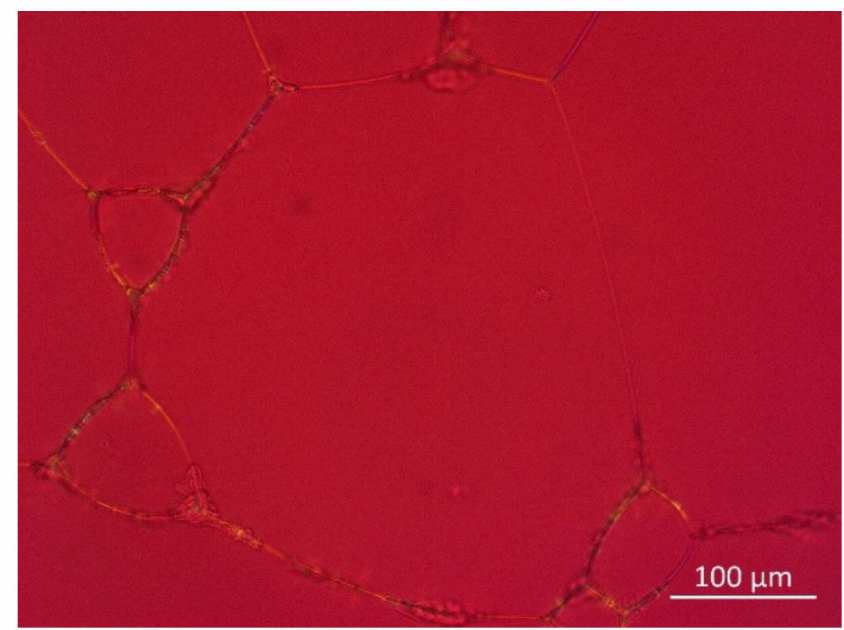
Figure 12. Polarization microscope image of dried-up foam generated from Premix